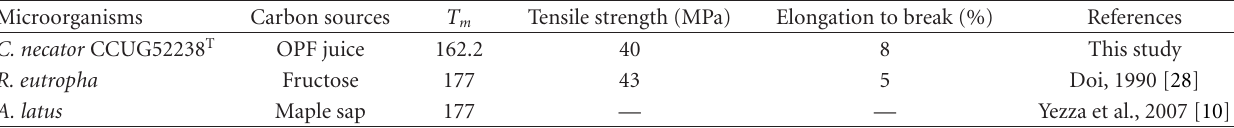
Table 5: Comparison of thermal and mechanical properties of P(3HB) obtained in this study with literature.